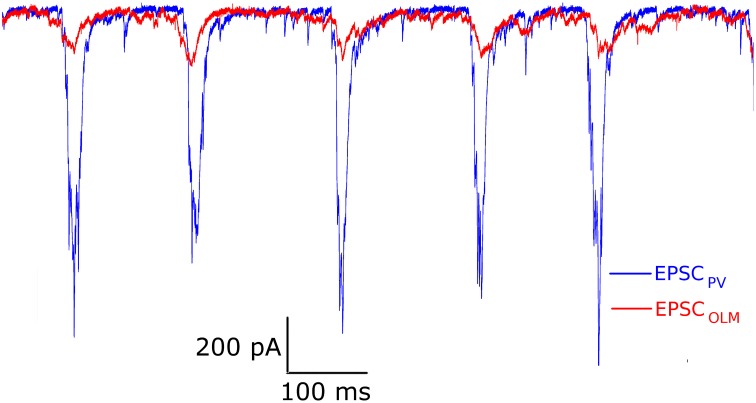
Example model excitatory postsynaptic current (EPSC) input drives to PV+ and OLM cell models (called EPSCPV and EPSCOLM, respectively), based on a modification of experimental EPSCs from voltage clamp recordings. Amplitudes and phases were varied to produce firing of PV+ and SOM+ cells as seen in experiment.